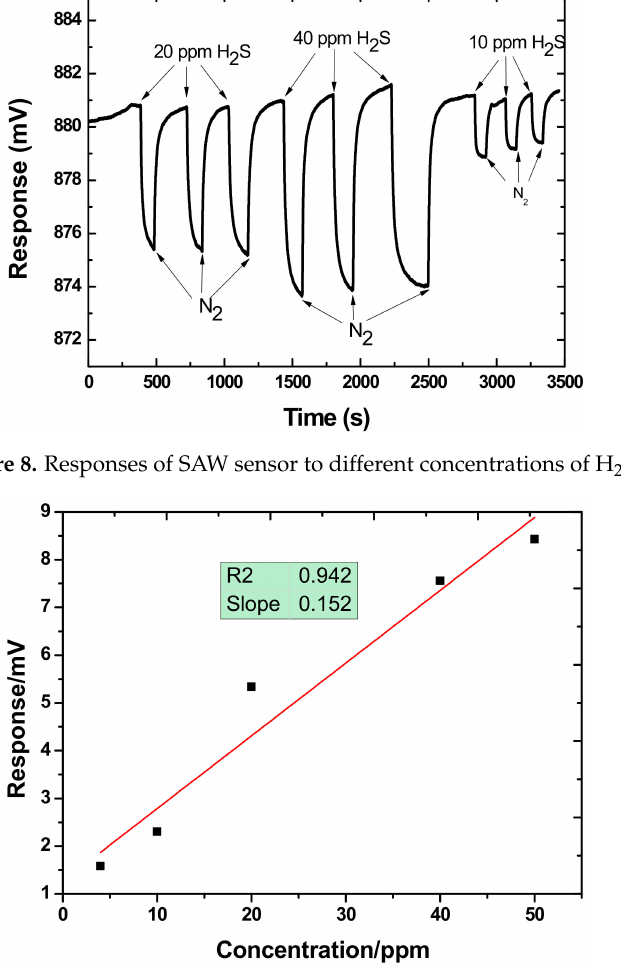
Figure 9. The sensitivity evaluation of the proposed SAW H 2 S sensor.